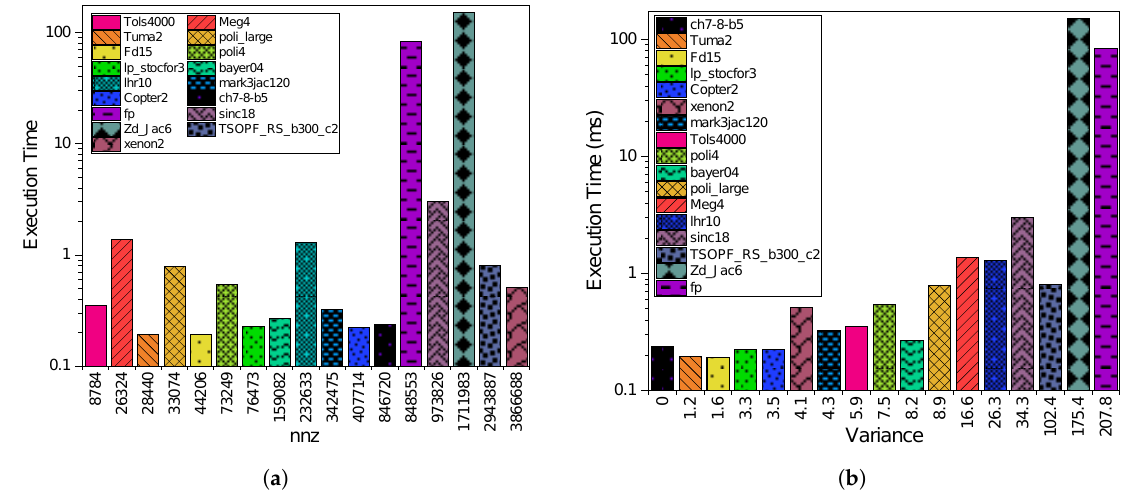
Figure 11. Hybrid ELL/COO (HYB) execution time against: ( a ) nnz and ( b ) npr variance